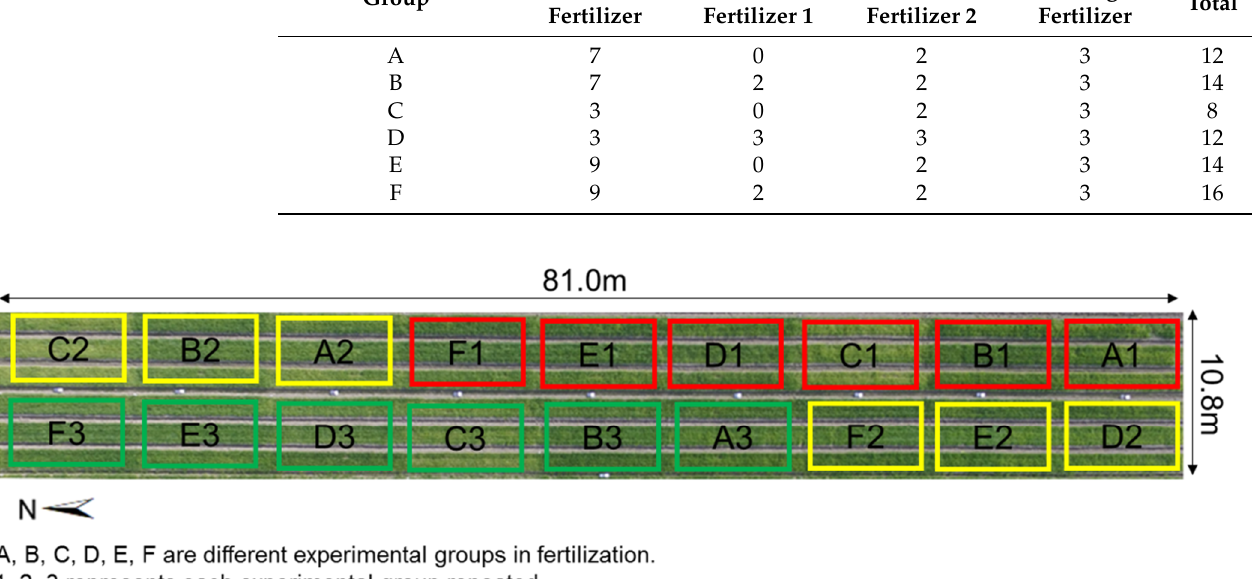
Figure 1. Experimental field map.